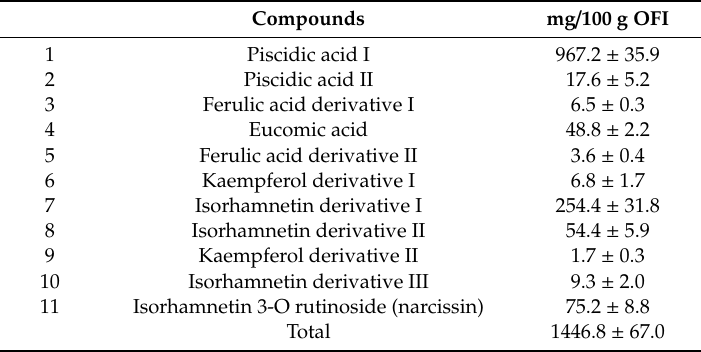
Table 1. Polyphenol content in Opuntia ficus indica